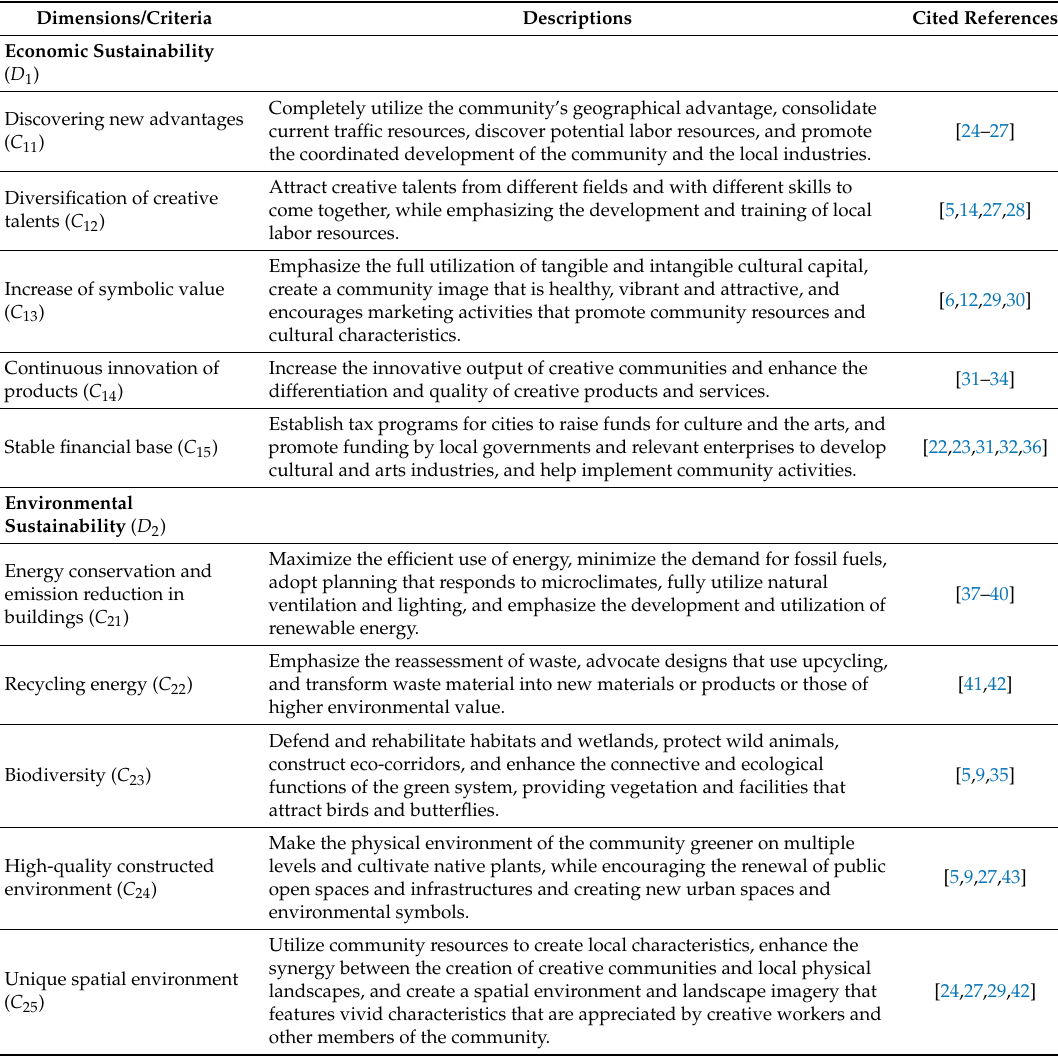
Table 1. Evaluation criteria and descriptions of the